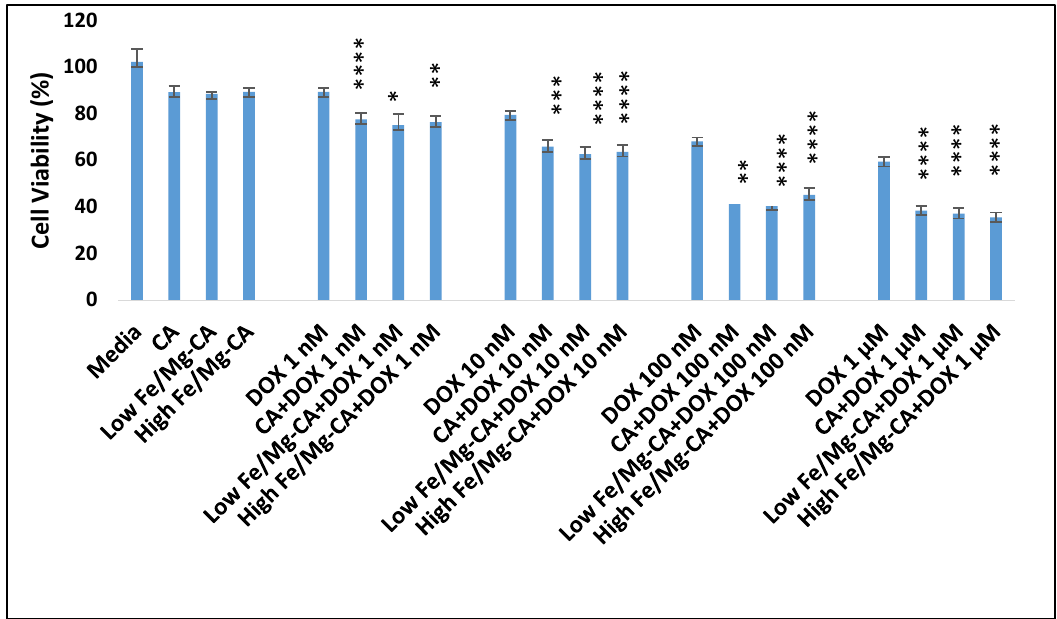
Figure 12. Cell viability assessment for free DOX, DOX-loaded CA, DOX-loaded low Fe/Mg-CA and DOX-loaded high Fe/Mg-CA by thiazolyl blue tetrazolium bromide (MTT) assay in Michigan Cancer Foundation-7 (MCF-7) cells after 48 h of treatment. Results were considered significant at p-value 0.01–0.05 (*), very significant at p-value 0.001–0.01 (**), highly significant at p-value 0.0001–0.001 (***) and extremely significant at p-value ˂ 0.0001 (****). P values were calculated with respect to control (DOX in media) and treatment (DOX-bound NPs). The confidence interval was 95% for the respective samples.